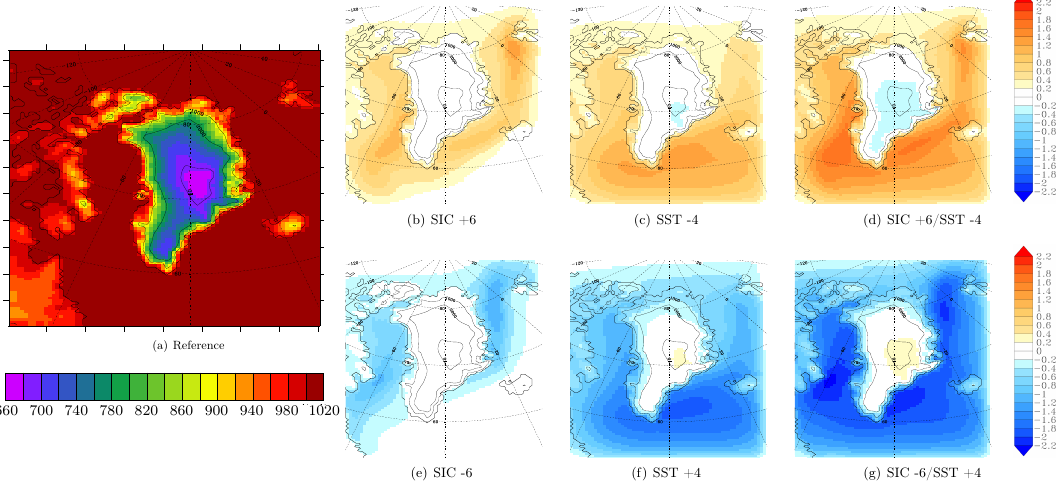
Figure 9. Annual mean surface pressure (hPa) for the reference run (a) over 2007–2012. Difference in annual mean surface pressure (hPa) between (b) SIC + 6, (c) SST − 4, (d) SIC + 6/SST − 4, (e) SIC − 6, (f) SST + 4, (g) SIC − 6/SST + 4 experiments and the reference run.